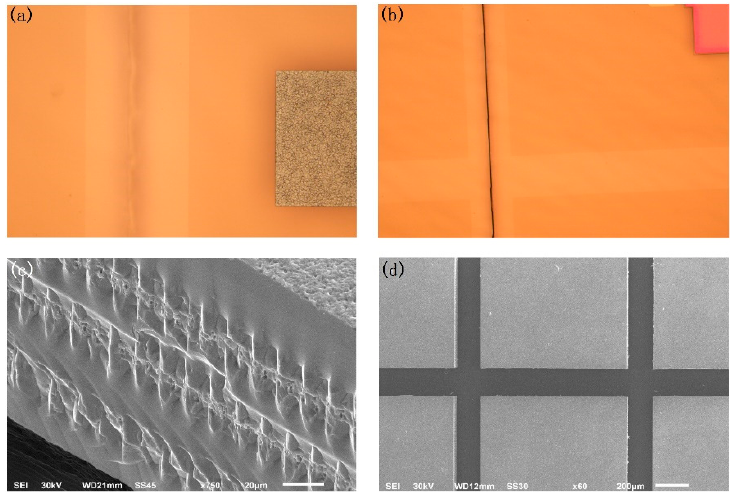
Figure 7. The results of cutting 200 μ m SiC. ( a ) The surface after the stealth dicing; ( b ) the thermal crack from the continuous laser; ( c ) the cutting profile; and ( d ) the final separation after the expand- ing